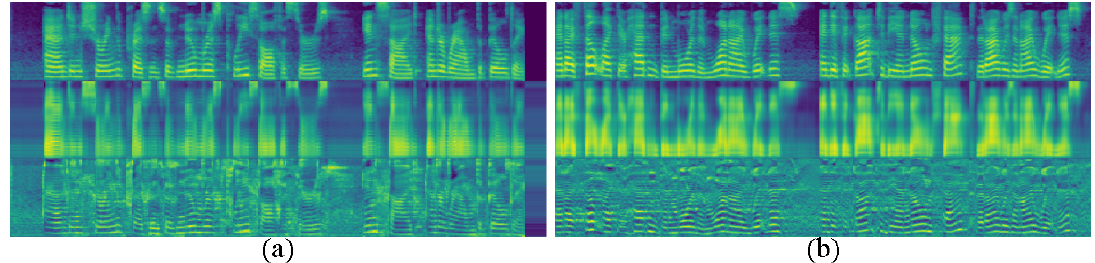
Figure 1. The comparison of different structure of Es-Network. ( a ) The structure of the token-based network; ( b ) The structure of the auto-encoder-based network.